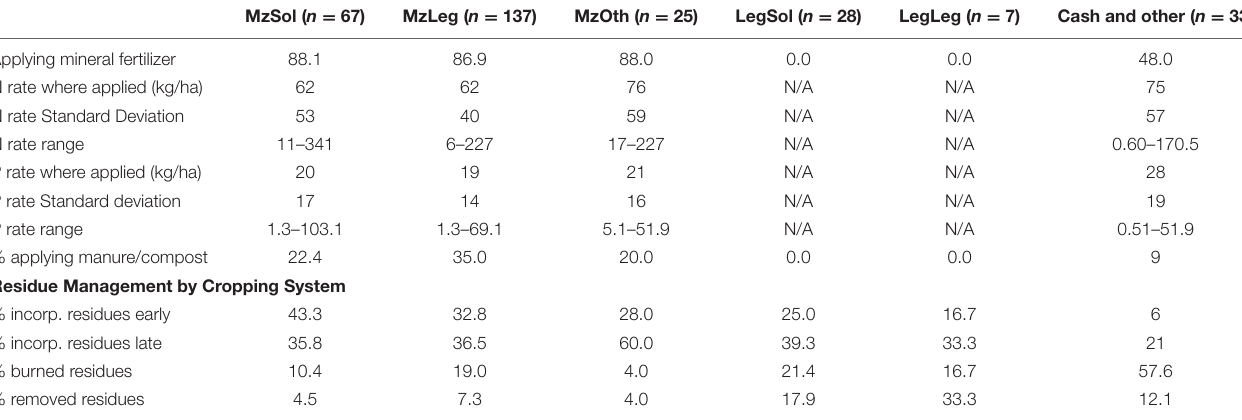
TABLE 7 | Inorganic fertilizer use, compost, and residue management practices by cropping systems, percentage by cropping system. MzSol ( n = 67) MzLeg ( n = 137) MzOth ( n = 25) LegSol ( n = 28) LegLeg ( n = 7) Cash and other ( n = 33) Applying mineral fertilizer 88.1 86.9 88.0 0.0 48.0